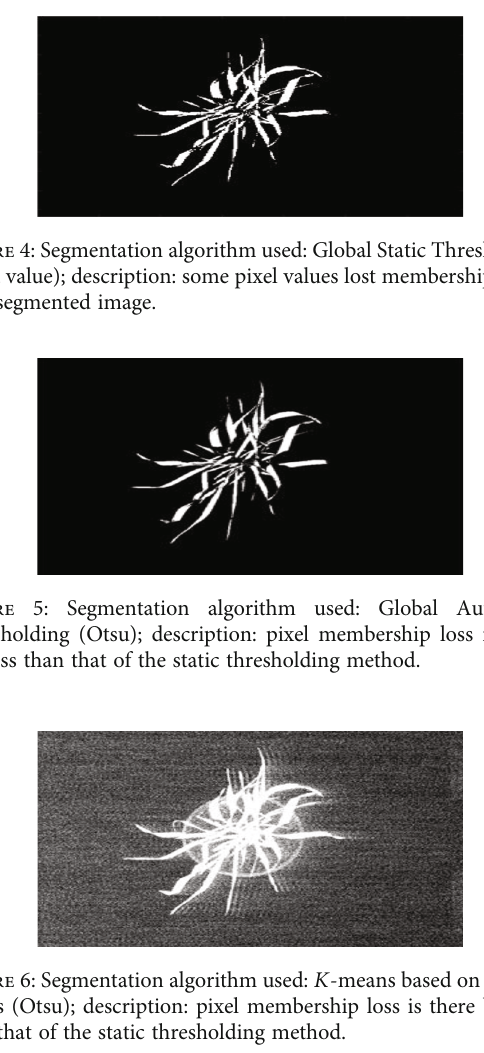
Figure 7: Segmentation algorithm used: watershed; description: the watershed algorithm failed to identify the boundaries